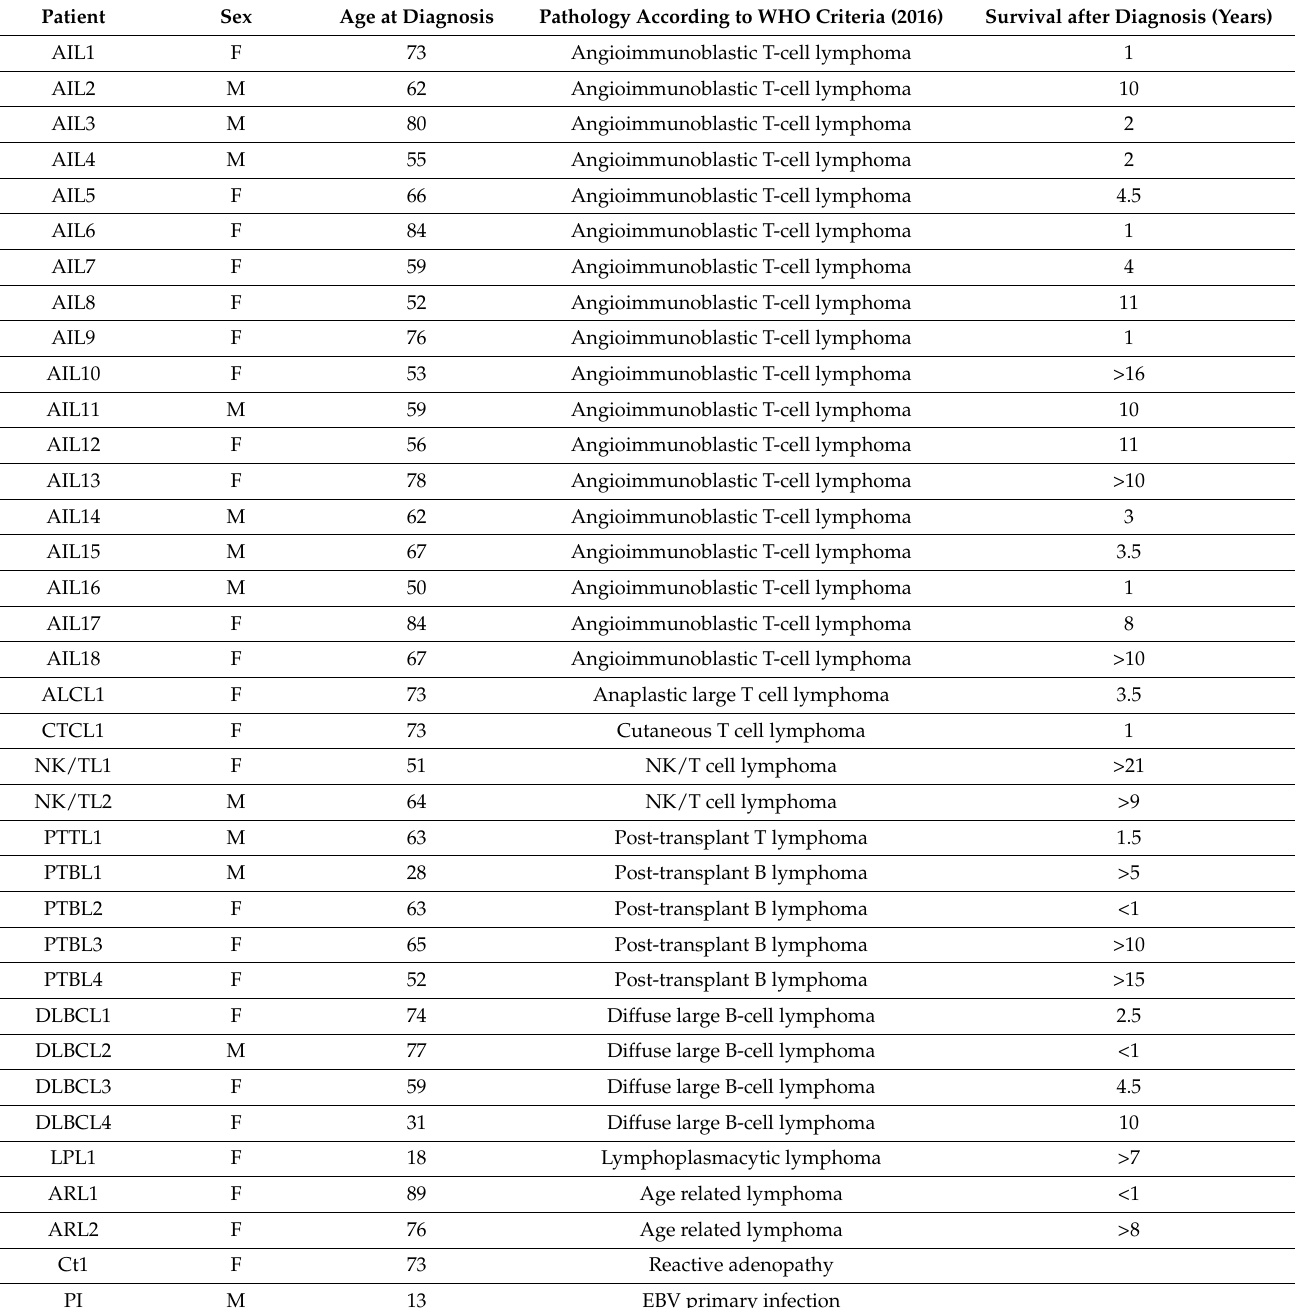
Table 1. Characteristics of the EBV-Associated Lymphoma Patients Included in this Study.